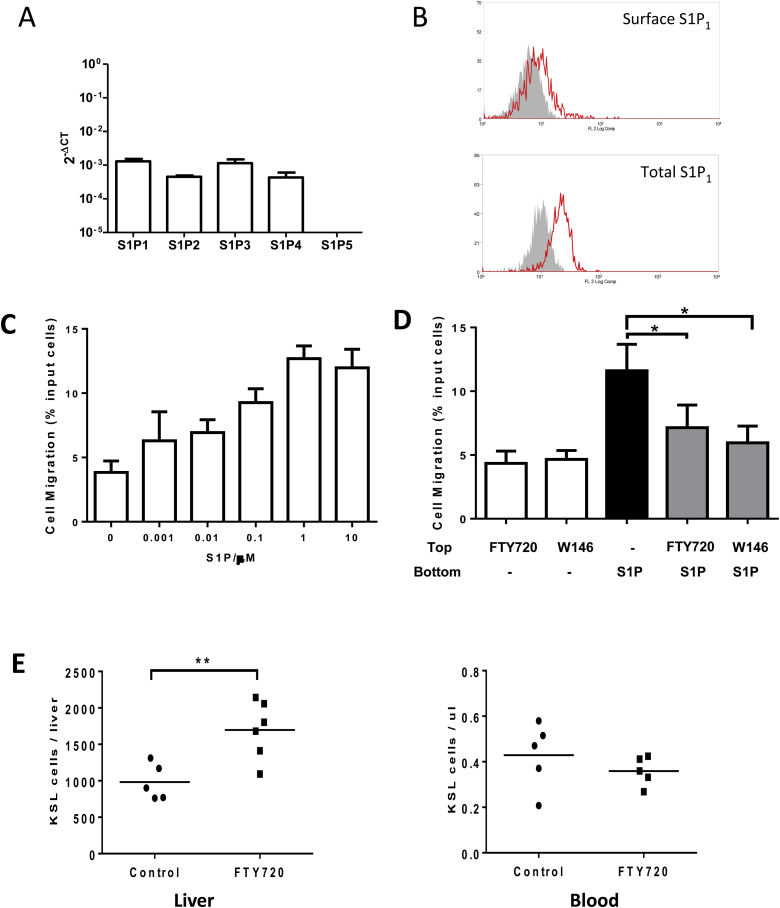
FTY720 alters HSC trafficking through modulation of S1P1. (A) Gene expression of S1P receptors 1–5 was determined in freshly isolated KSL cells relative to glyceraldehyde-3-phosphate dehydrogenase by the 2-ΔCT method. Bars represent means ± SEM expression in 3 independent experiments. (B) Surface and total S1P1-receptor expression on freshly isolated KSL cells was analyzed by flow cytometry. Representative histograms of 3 independent experiments are shown (grey area, isotype control; red line, S1P1 antibody). (C) A total of 1 × 105 KSL cells were added to the top well of a Transwell and migration to varying concentrations of S1P was assessed over a 4-hour period. Cells migrating into the bottom well were analyzed for expression of c-kit and sca-1 and quantified by flow cytometry. KSL cells migrating to the lower well were expressed as a percentage of the total number of KSL cells added to the top well. Bars represent the means ± SEM of 3 separate experiments. (D) S1P-receptor dependence of migration of KSL cells to S1P was assessed by placing cells in the upper chamber of a Transwell and quantifying their migration to the presence or absence of S1P in the lower chamber. Treatment of KSL cells with either FTY720 (S1P-receptor partial agonist) or W146 (S1P-receptor 1 antagonist) inhibited their migration to S1P in Transwell assays (3 independent experiments). (E) Administration of daily intraperitoneal FTY720 (1 mg/kg) for 7 days in CCl4-injured mice resulted in an increased number of KSL cells in the liver but circulating KSL cells remained unchanged (n = 6 per group; 2 independent experiments). *P < .05 and ∗∗P < .01.